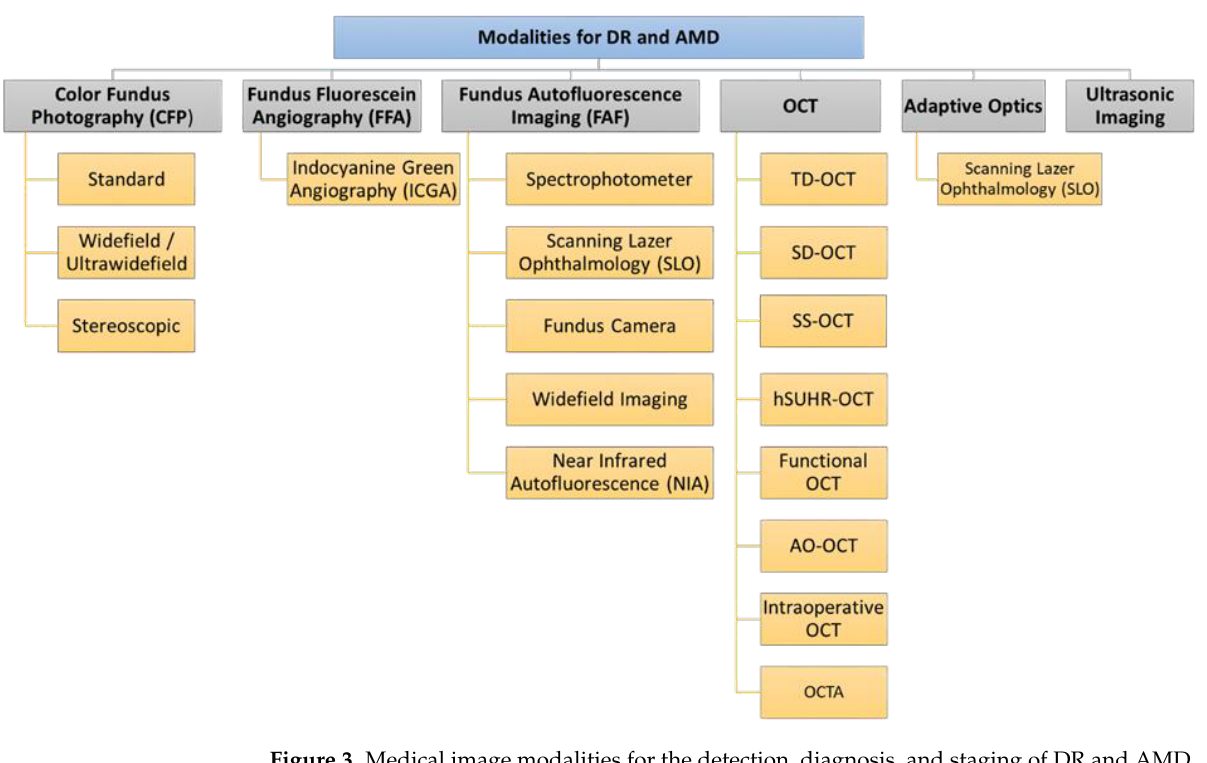
Figure 3. Medical image modalities for the detection, diagnosis, and staging of DR and AMD.